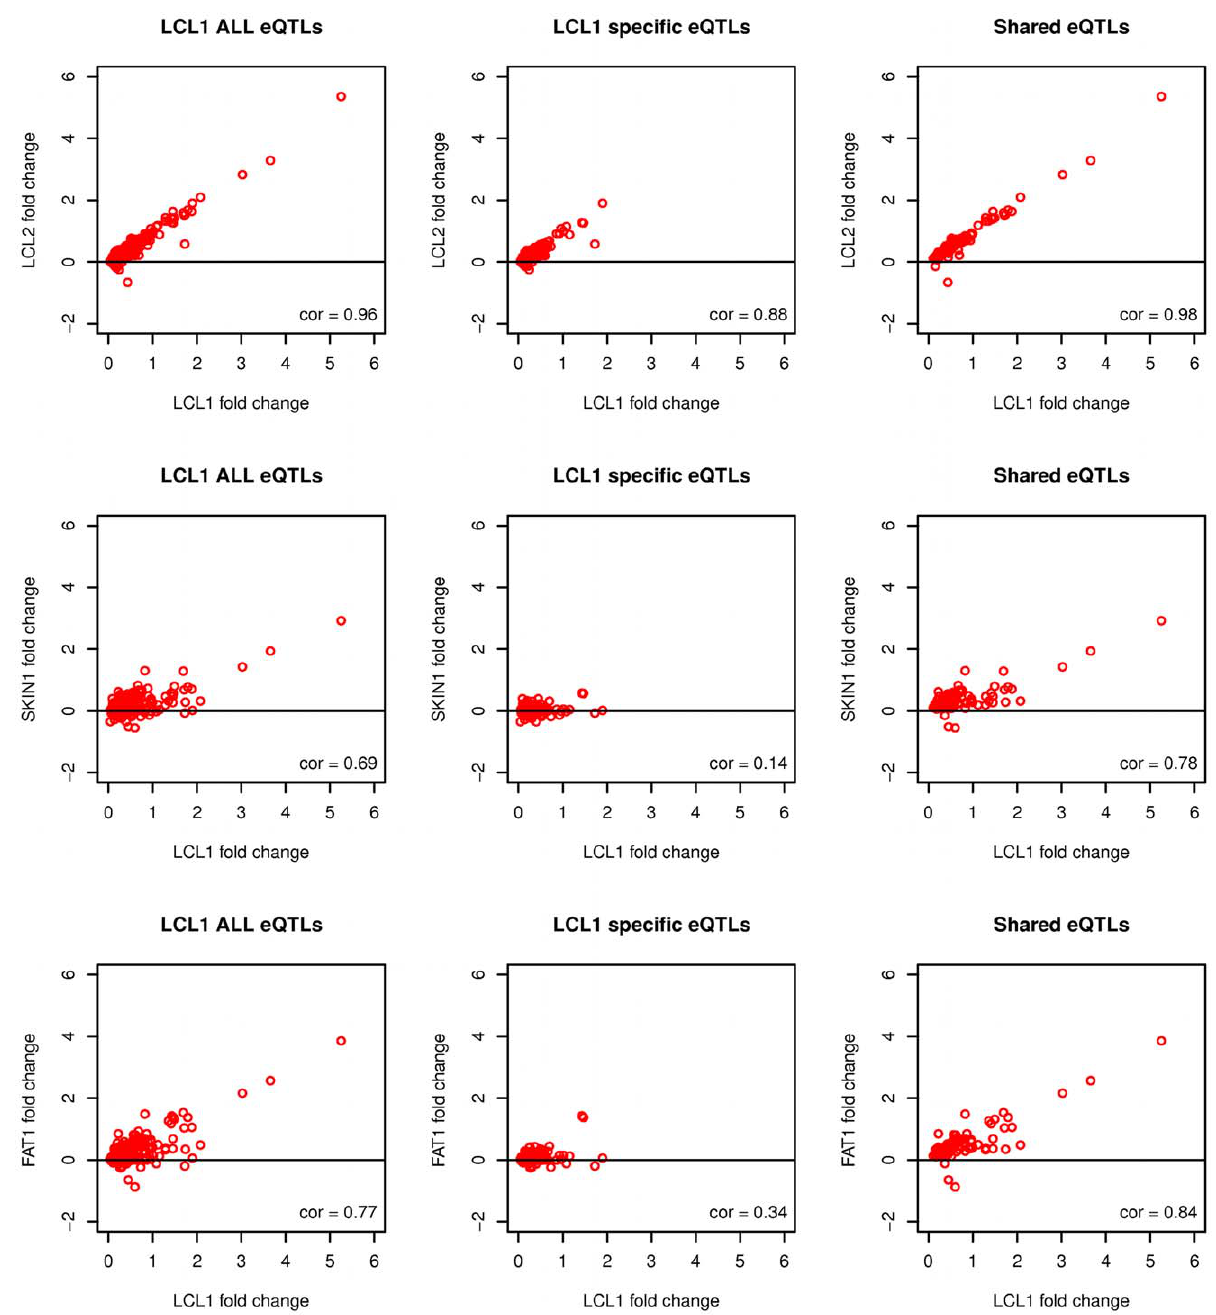
Figure 3. Fold change within twins and across tissues for LCL eQTLs (10 2 3 PT, SRC) discovered in Twin 1. The plotted fold change on the X-and Y-axes was calculated as the difference in mean expression of the heterozygous and major homozygous genotypic classes. For each pairwise tissue comparison, the Pearson’s correlation coefficient between fold changes is shown.